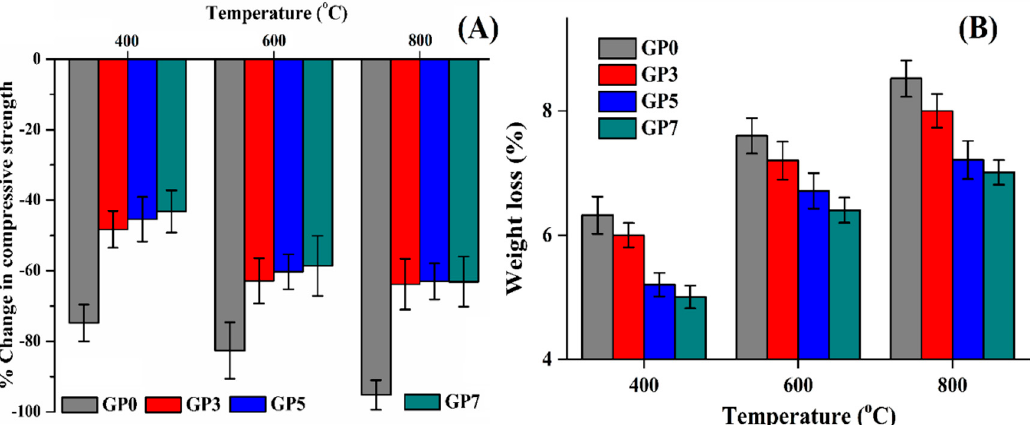
Figure 7. Exposure of geopolymer specimens at different temperatures: ( A ) % change in compressive strength; ( B ) % weight loss.